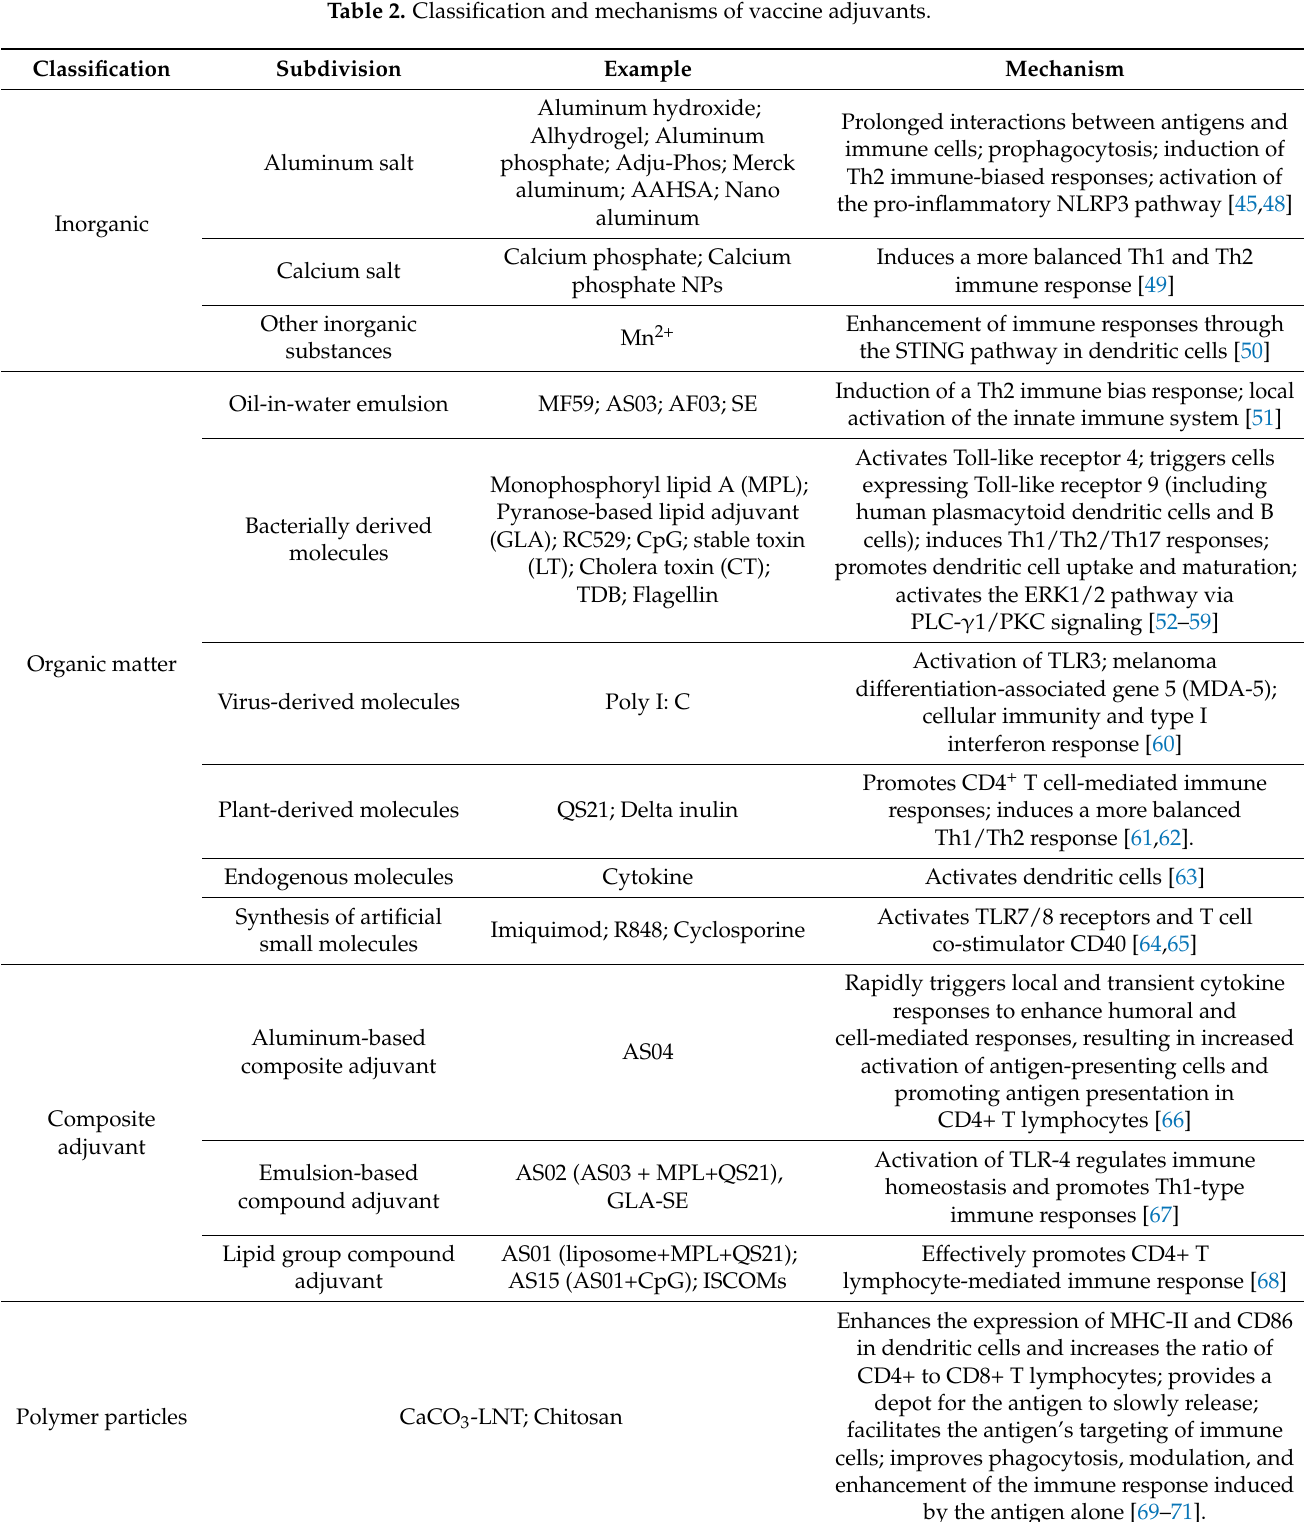
Table 2. Classification and mechanisms of vaccine